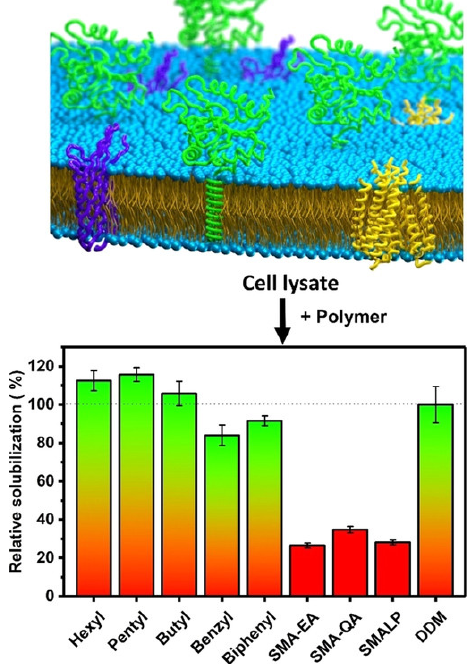
Figure 14. E. coli membrane solubilization by inulin-based non-ionic polymers possessing different types of hydrophobic functional groups (see Figure 2 for the chemical structure). The solubilization efficacy of inulin-based polymers is compared with that of SMA-based polymers and DDM. This Figure and caption are adopted from reference [202] with copyright permission.